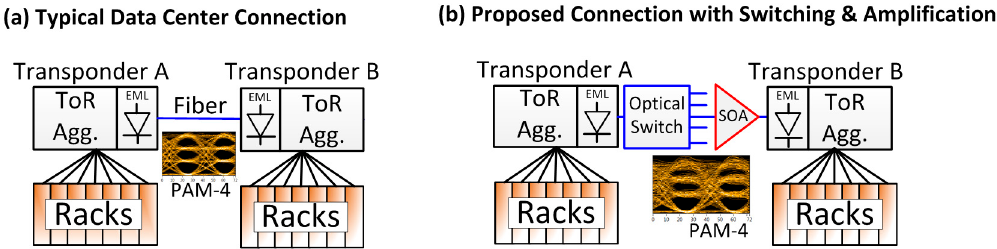
Figure 1. ( a ) Simplified schematic showing communication between two clusters of racks in a datacenter. The transponders use externally modulated lasers (EML) to communicate at up to 400 Gbit/s between the top of the rack aggregators (ToR Agg.); ( b ) Proposed use of semiconductor optical amplifiers (SOA) as a pre-amplifier to overcome losses within an optical switch. Eyediagrams of the simulated PAM4 signals are shown, in ( b ) a slightly distorted eyediagram due to the SOA nonlinearities are shown.